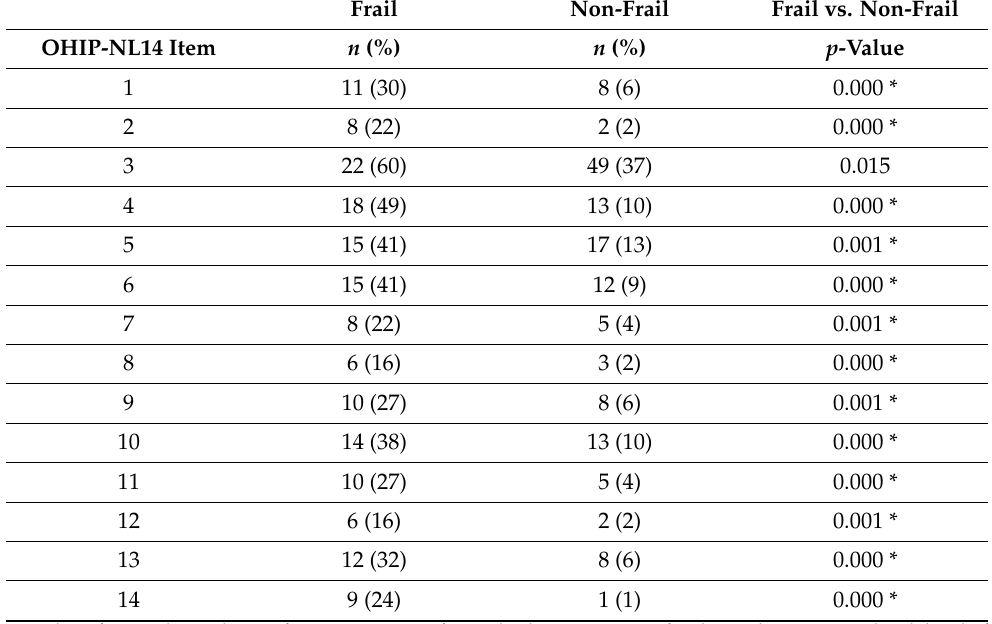
Table 3. Differences in scoring for each OHIP-NL14 item between frail and non-frail community- dwelling older